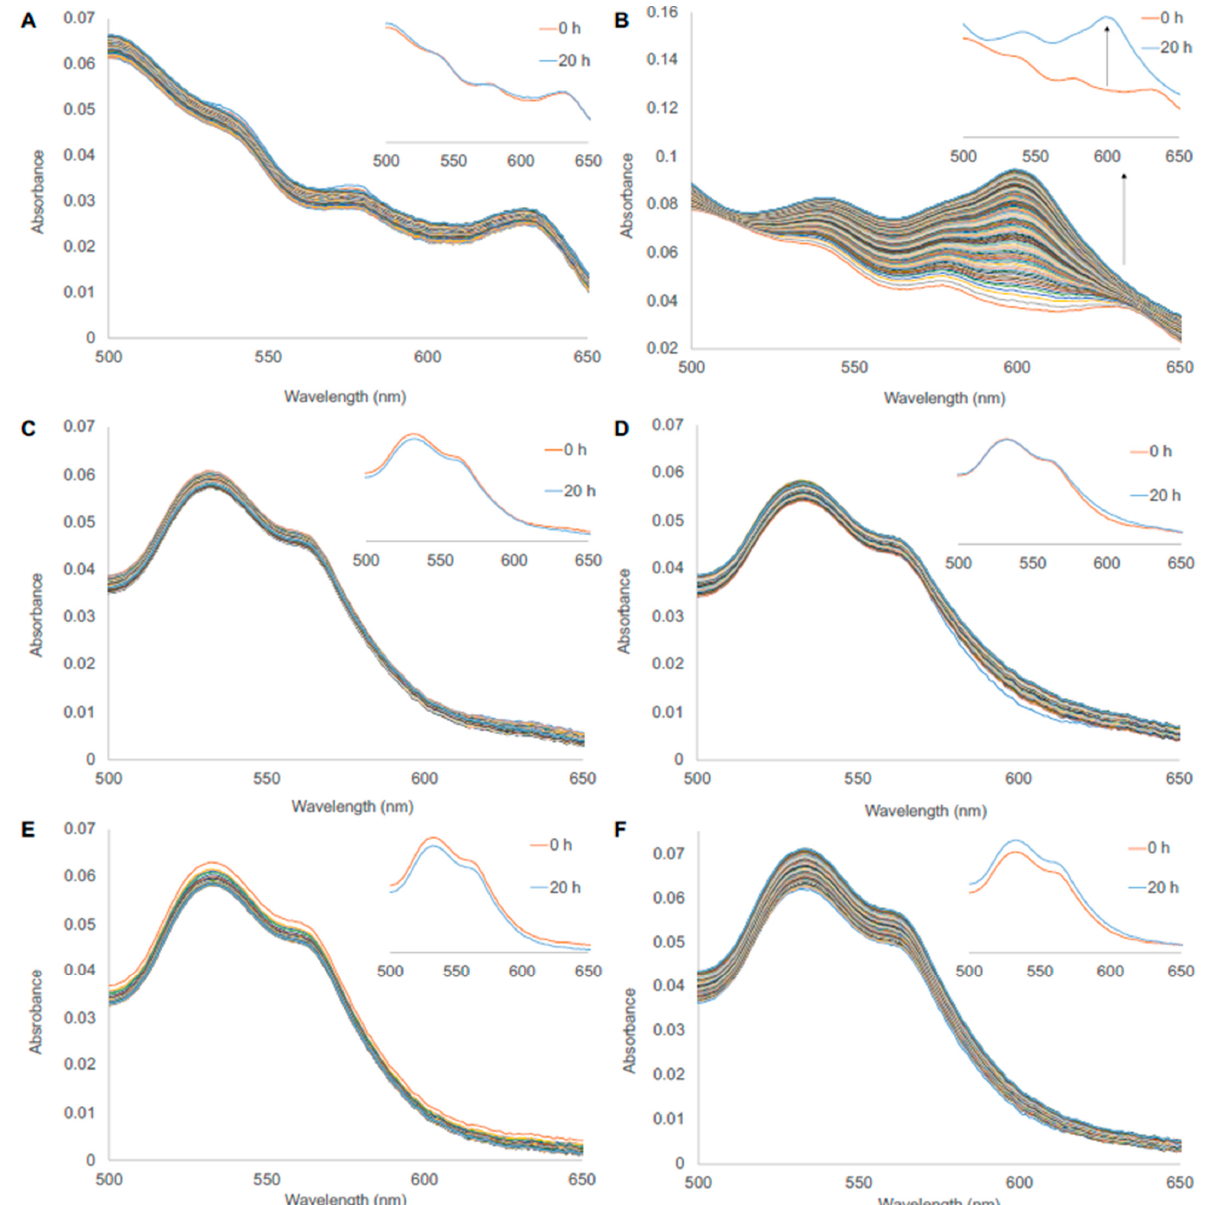
Figure 4. Heme-loss assay using ApoMb as a heme-scavenger. ( A , B ) Fetal hemoglobin (HbF) blank sample and addition of ApoMb, respectively. The blank sample retained the initial spectrum after 20 h, while the Mb spectrum was detected in the right panel, most predominately seen as an increase in absorbance at 600 nm. ( C , D ) BvPgb1.2 WT blank sample and addition of ApoMb, respectively. In both cases, the initial spectra remained constant, i.e., no Mb spectrum at 600 nm could be detected. ( E , F ) BvPgb1.2 Cys86Ala blank sample and addition of ApoMb, respectively. In both cases, the initial spectra remained constant, i.e., no Mb spectrum at 600 nm could be detected. All experiments were conducted at 25 °C; spectra were measured in 10 min intervals for 20 h, and the ferric form of the Hbs was used.